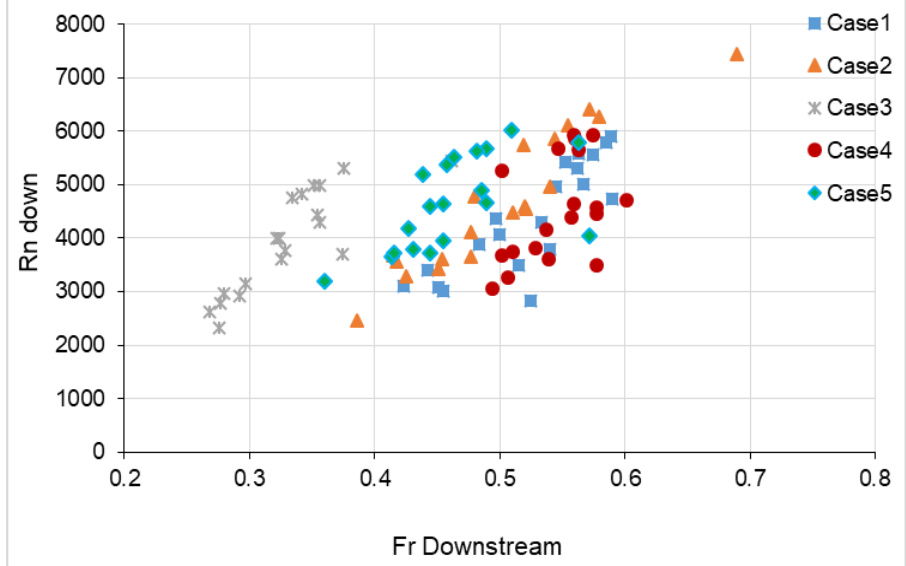
Figure 11. Relation between Reynolds number and Froude number at downstream